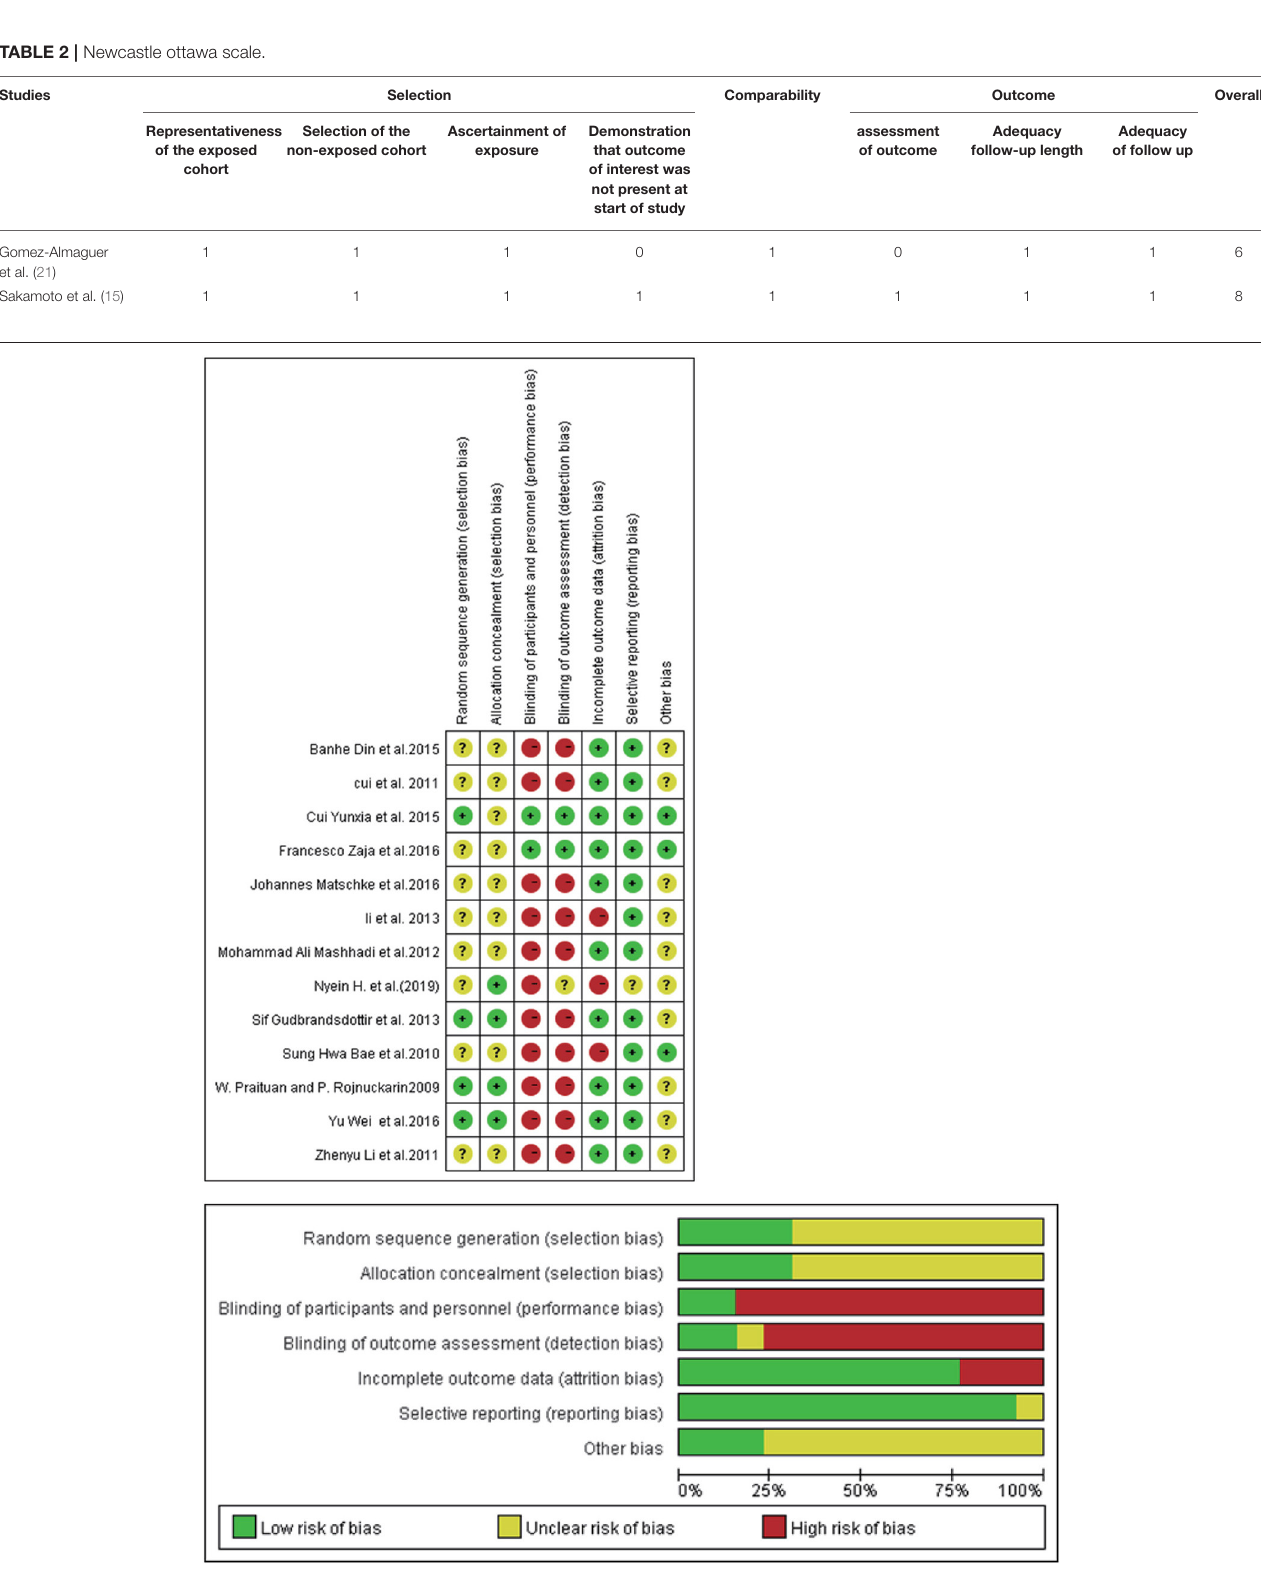
FIGURE 2 | Risk of bias summary: review authors’ judgements about each risk of bias item for each included study.